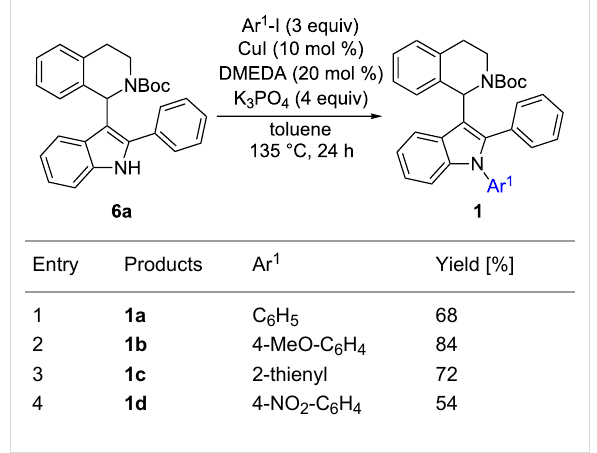
Table 8: Scope of copper catalyzed N-arylation of 6a